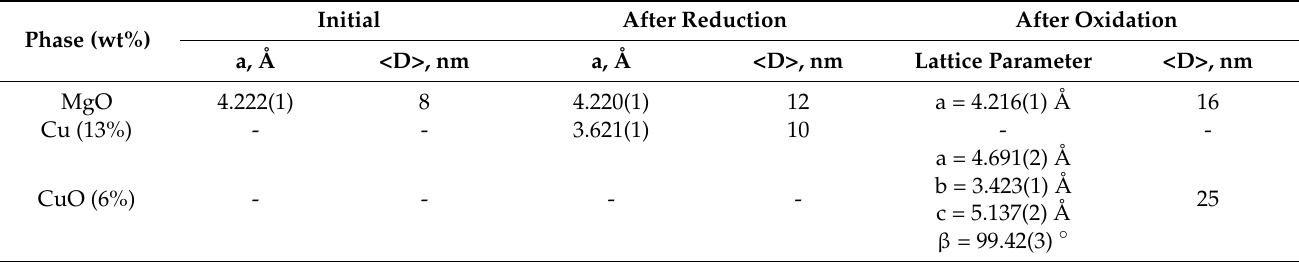
cell edges meeting at a vertex, and the angle β between edges a and c) obtained from the XRD